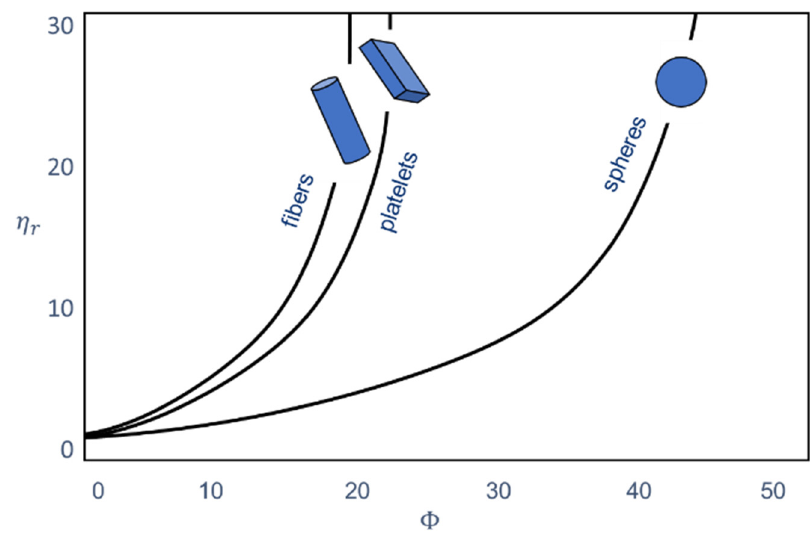
Figure 1. Influence of the filler content and the particle shape on the relative viscosity of plastics [5]. The relative viscosity is the ratio of the viscosity of the filled plastic to the viscosity of the unfilled plastic. The information on the filler content is based on the volume.